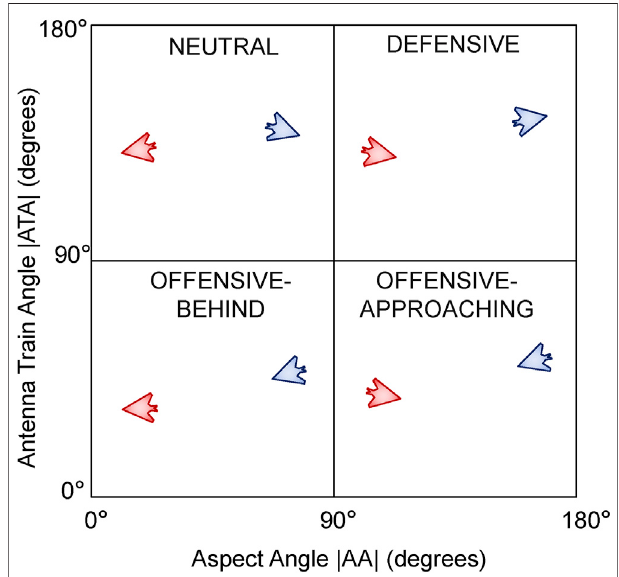
FIGURE 9 | Relative orientation con fi gurations de fi ning the Blue UAV ’ s posture relative to the Red UAV.